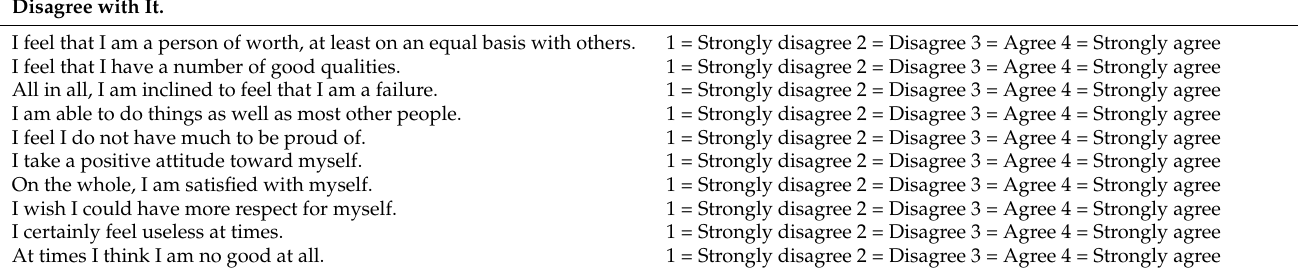
Table A3. The Rosenberg Self-Esteem Scale.